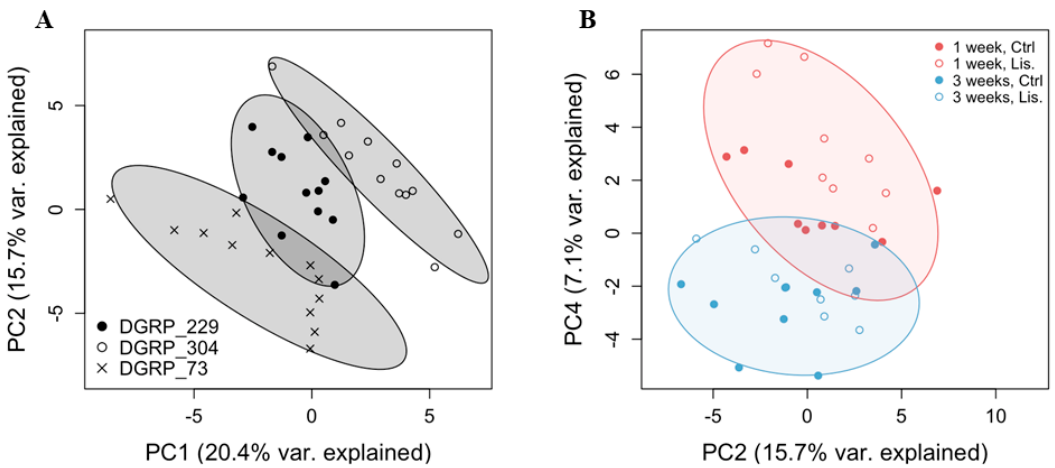
Figure 2. Principal component analysis of thoracic metabolomic profiles. ( A , B ) Principal component (PC) scores are produced by metabolic features detected by LC/MS in both positive and negative ion modes. While PC1 and PC2 separate samples by genotype (panel A ), PC4 almost completely separates samples by age (panel B ), and it is plotted here against PC2. In both panels, ellipses represent 90% confidence intervals of the groups.